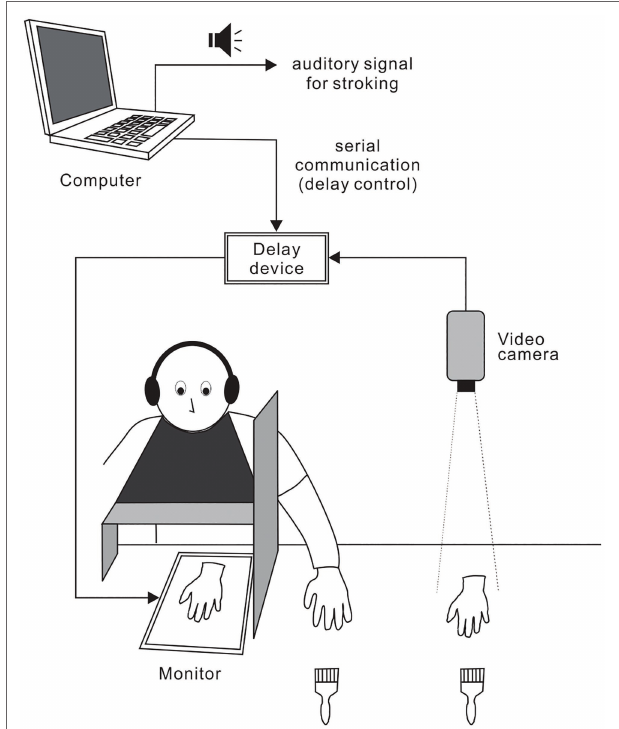
FIGURE 1 | Experimental setup. Subject’s left hand and fake left hand were stroked simultaneously with paintbrushes to induce the rubber hand illusion (RHI). Video images from the top view of the fake hand were displayed on a monitor. Using a video delay device, four delay intervals (i.e., 80, 280, 480, or 680 ms) were introduced. Delay intervals could be changed instantaneously by signals from a computer.